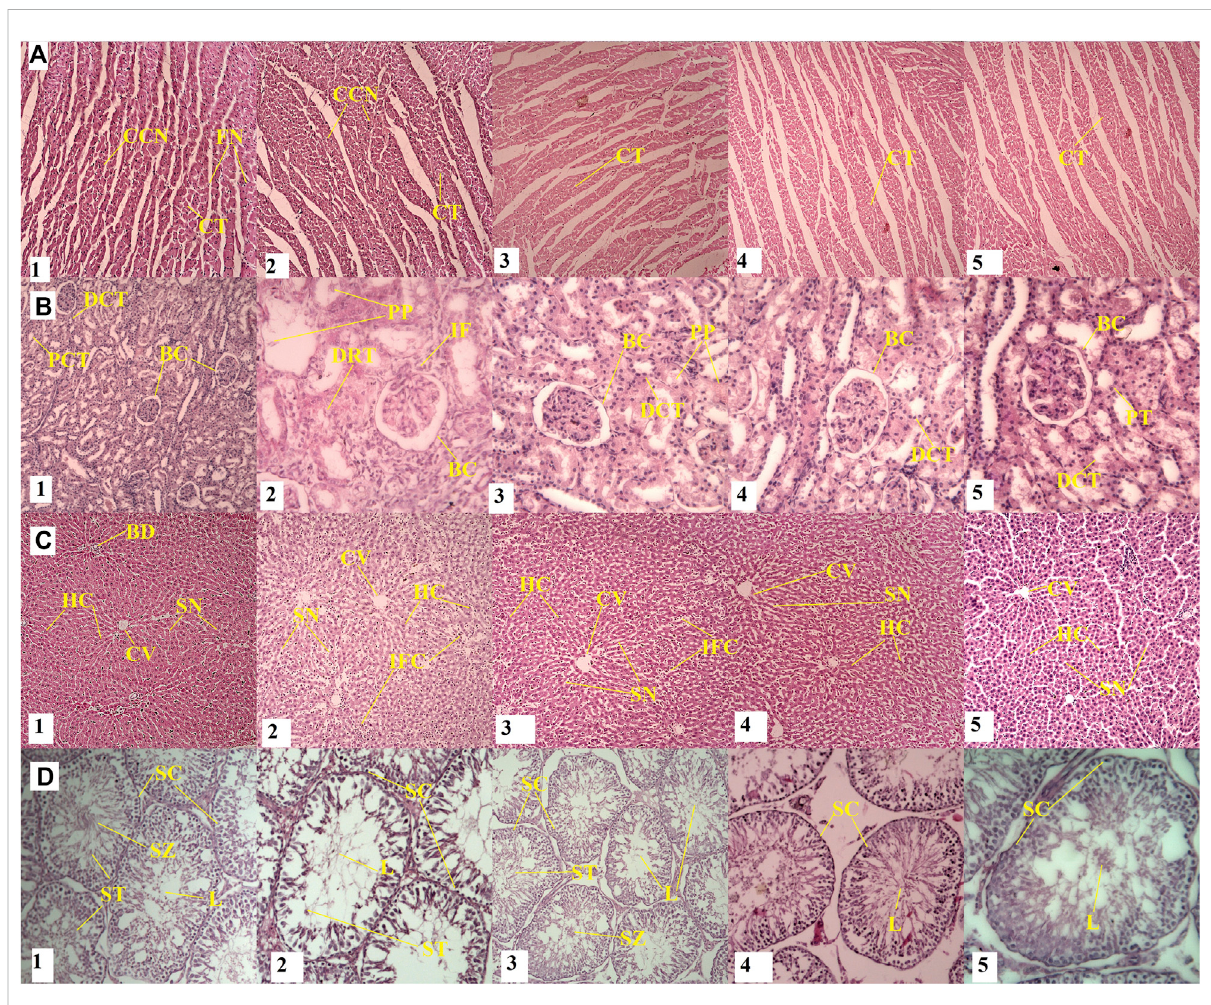
FIGURE 4 Effect of withametelin on the histology of organs. In the kidneys (B2 and B3), a mild in fi ltration of mononuclear in fl ammatory cells around tubules and the degeneration of epithelial cells, renal glomerular capsule space distention, interstitial swelling and congestion, and Pink proteinacious material at5 mg/kg withametelin(B3) wereseen. Tested in thetreatment group with withametelin (5 mg/kg) (D2) showed an increase in the interstitial space between the seminiferous tubes, an increase in the lumen size and spermatogenesis stages showed mild sloughing. In the liver, there was an increase in the sinusoidal space, a slight in fi ltration of in fl ammatory cells, swelling, and sinusoidal congestion in 5 (C2) and 2.5 (C3)mg/kggroupsincomparisontocontrol wasobserved. Nohistological changeswereseeninheart.A-Drepresents, heartkidney,liverandtestes respectively. 1-5 represents different dose groups i.e., normal or vehicle, 5, 2.5, 1.25, and 0.75 mg/kg. CCN; Cardiac cell nucleus, CT, Cardiac tissue; FN, Fibroblastnucleus; BC,Bowman ’ sCapsule; DCT, Distal convoluted tubules; PCT, Proximal convoluted tubules; PP, Pink proteinaceous material; DRT, Damaged renal tubule; BD, Biliary duct; HC, Hepatocytes; SN, Sinusoids; CV, Central vein; IFC, In fl ammatory cells; SC, Spermatocytes; SZ, Spermatozoa; ST, Spermatids; L,